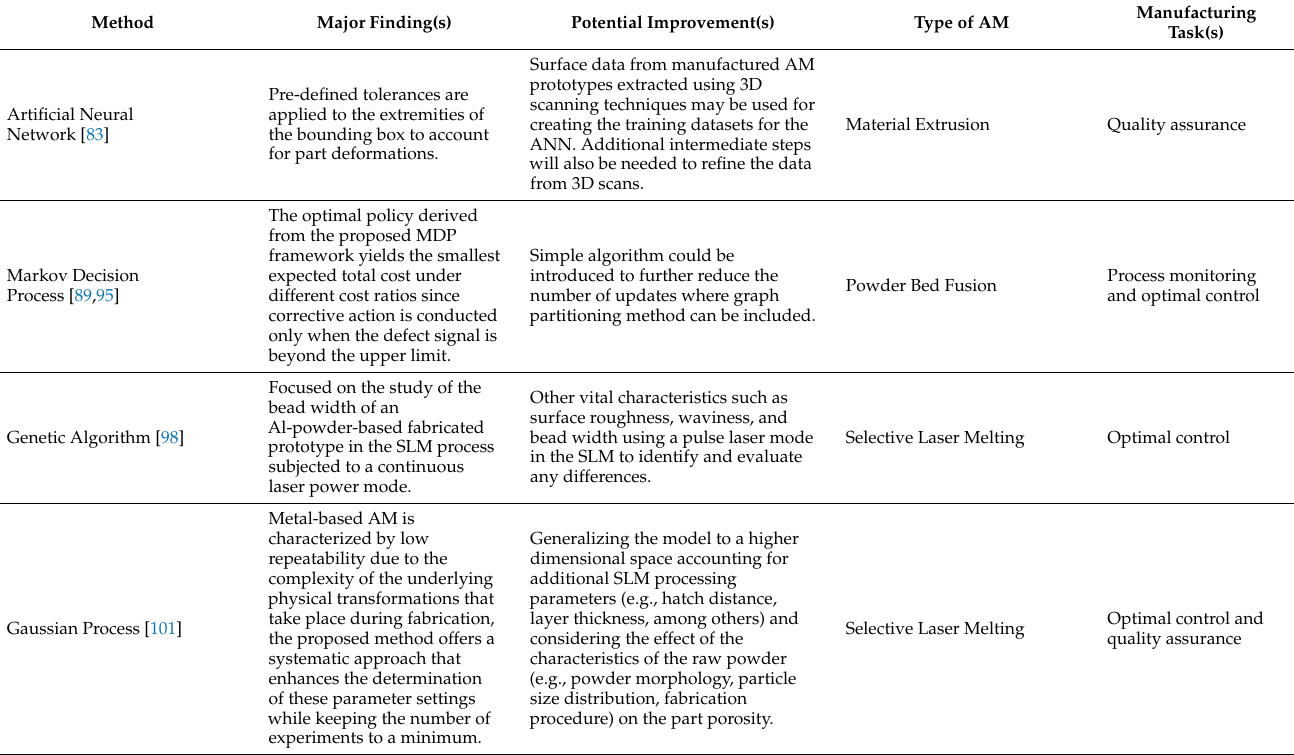
Table 4. Major findings on data-driven AI based methods and their potential improvements.